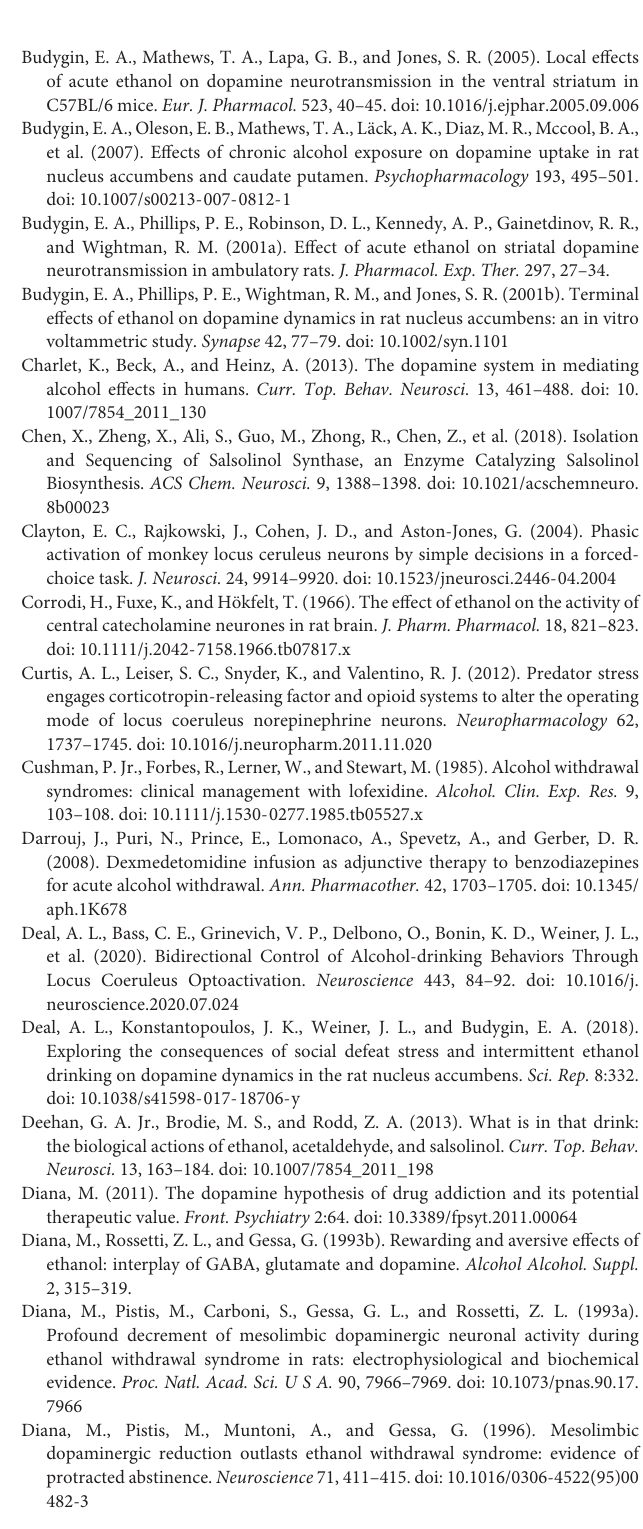
Supplementary Table 1 | The findings from studies exploring consequences of optogenetic interventions on ethanol consumption in two different behavioral paradigms. Blue light stimulations with distinct patterns (tonic and phasic) were conducted through chronic implantable optic fibers, which were connected to a